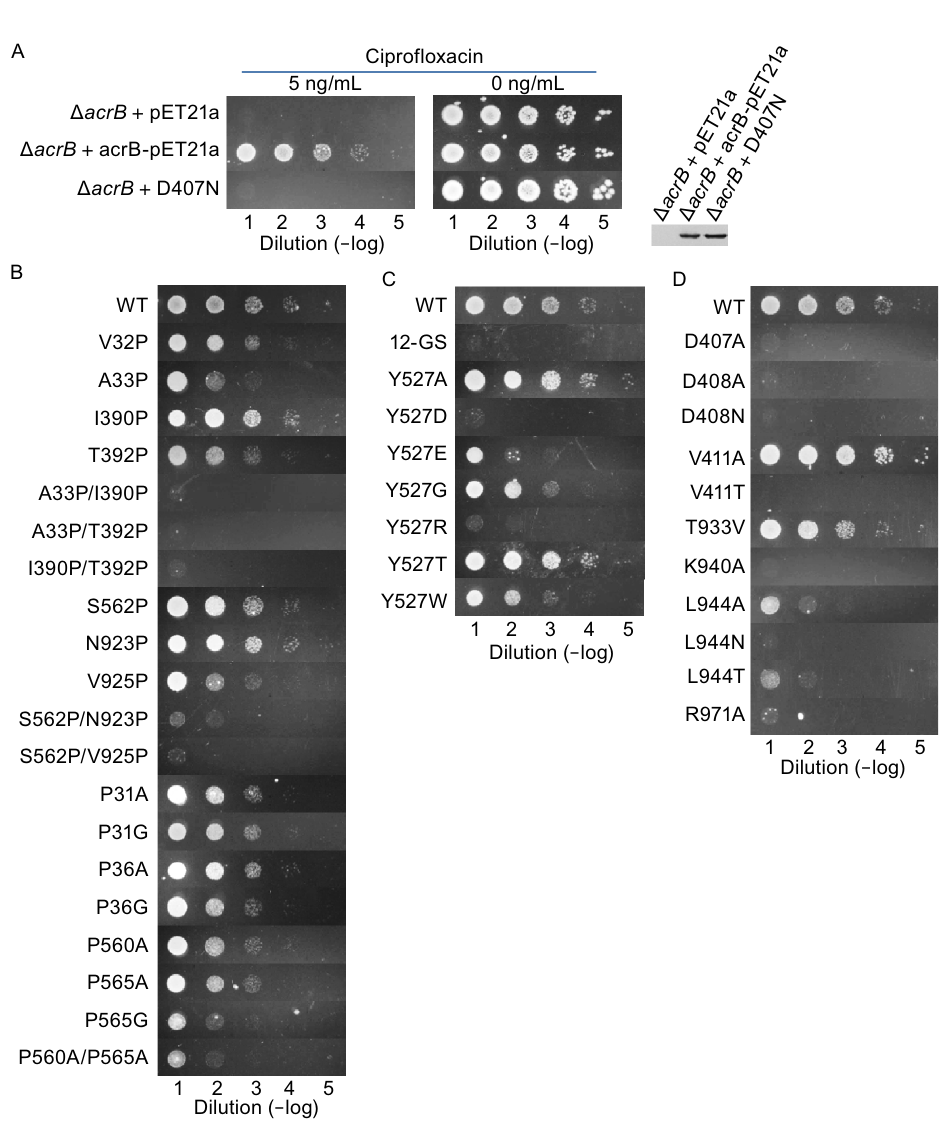
Figure 2. Anti-cipro fl oxacin complementation assay . (A) A serial dilution of cell culture spotted onto solid medium containing 100 µg/mL ampicillin and 5 ng/mL cipro fl oxacin. Compared with the empty-vector (pET21a) and predicted protonation-site mutant D407N containing strain, the wild type AcrB constructed in pET21a showed apparent resistance against cipro fl oxacin. Leaky expression of AcrB was con fi rmed using anti-His immunoblotting. (B) Mutational effects in the two signaling motif